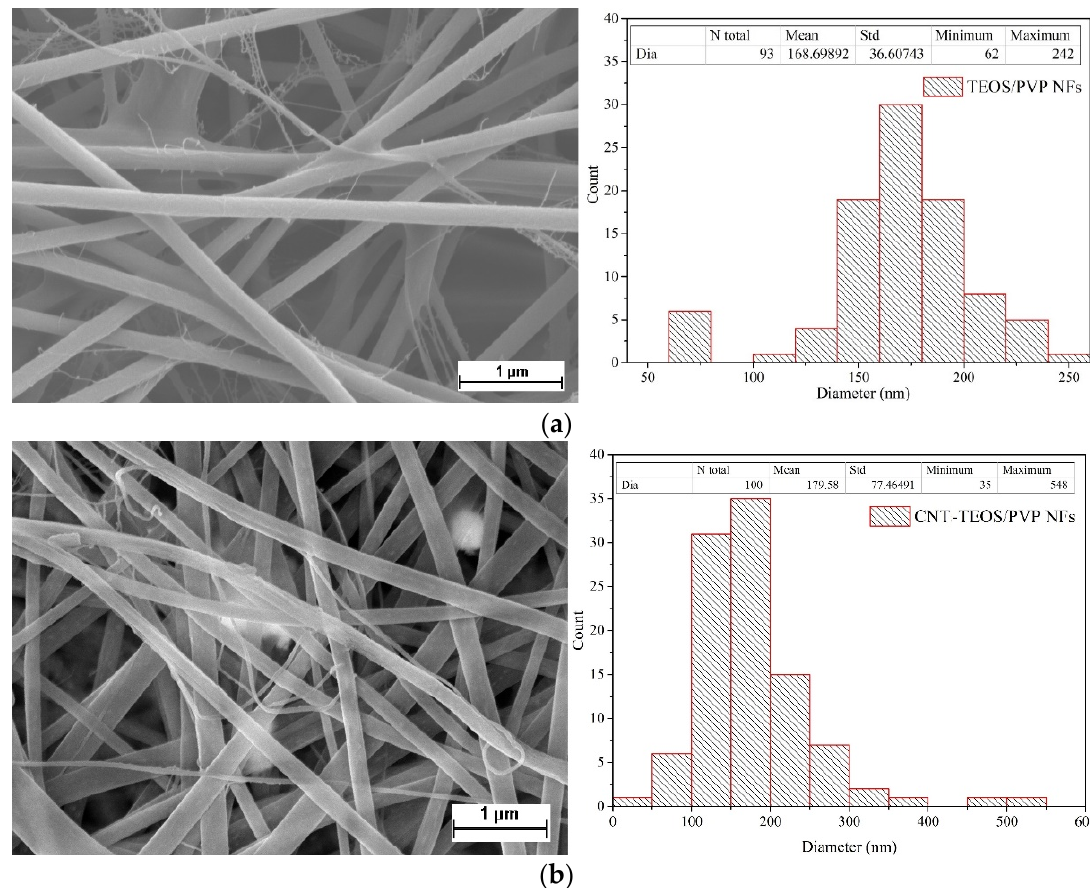
Figure 6. SEM image of nanofibers: ( a ) TEOS/PVP NFs; ( b ) CNT-TEOS/PVP NFs.